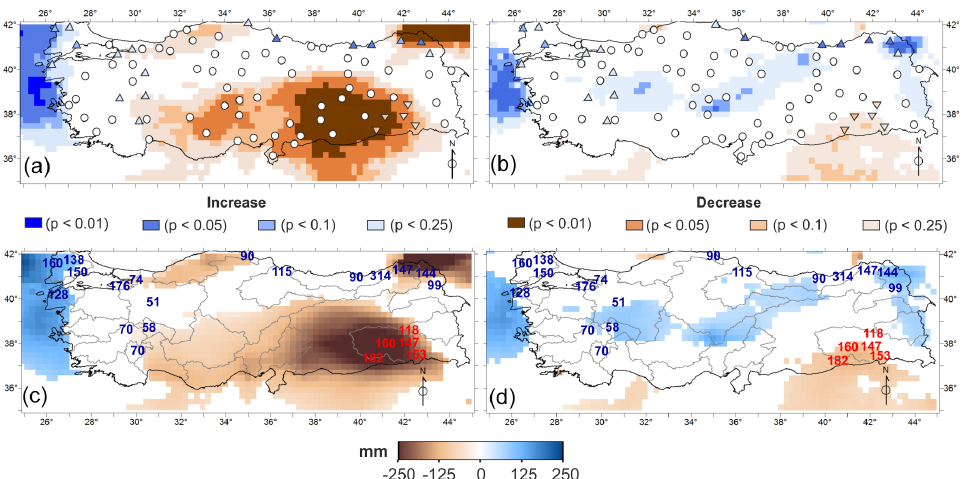
Figure 4. The comparison of the presence of the significant total precipitation trends by (a) ERA-Interim vs. in situ data and (b) Interim/Land vs. in situ data. The comparison of the magnitudes of 32-year total precipitation trends by (c) ERA-Interim vs. in situ data and (d) In- terim/Land vs. in situ data. In (a) and (b) , the upward/downward triangles indicate the significant increasing/decreasing trends, circles indicate no trend and the colors indicate the degree of the significance. In (c) and (d) , the numbers indicate the total increasing/decreasing trends observed at the stations that have significant trends. The polygons in (c) and (d) delineate the 26 water basins in the country.